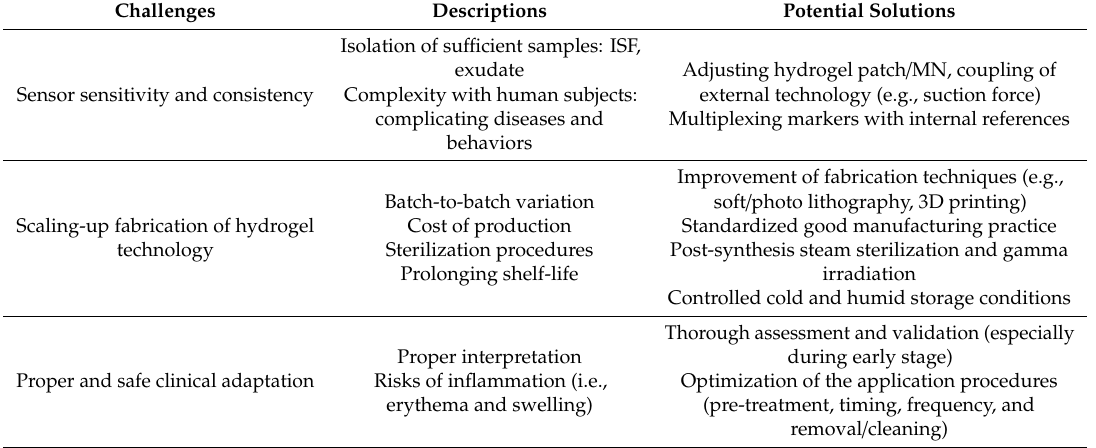
Table 1. Challenges and potential solutions in translating hydrogel technology to monitor pathological skin